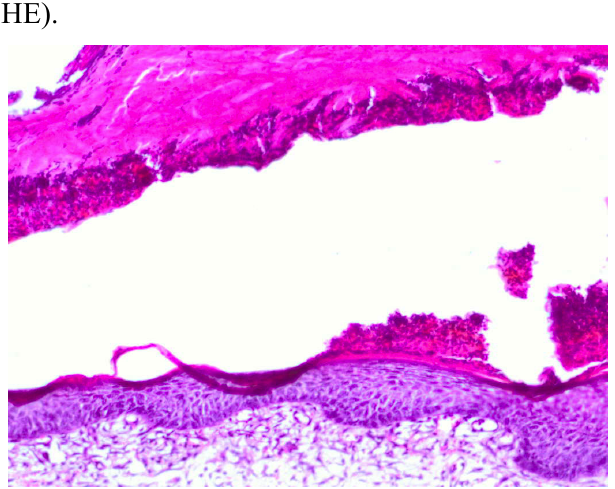
Figure 6. Day 21, K2-dermazin, crust visible at wound edges visible, fresh granulation tissue underneath, inflammatory infiltration, visible unobstructed blood vessels (enlargement 150×, HE).